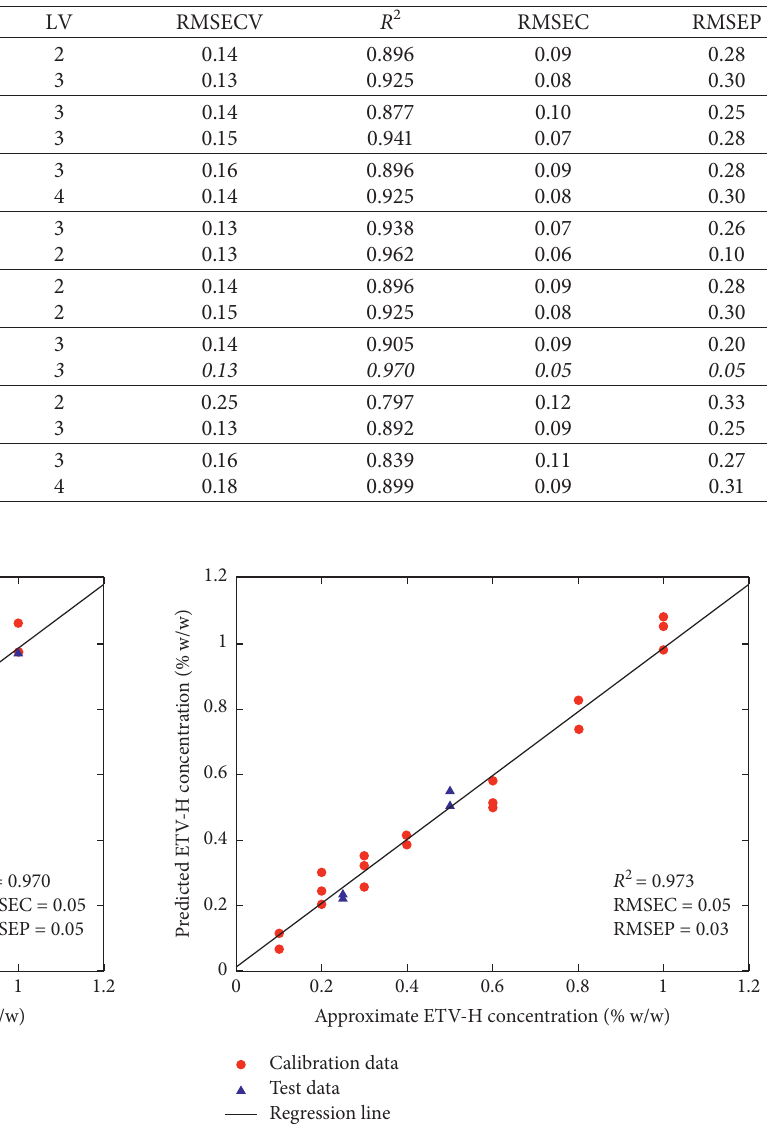
Figure 6: Approximate vs. predicted ETV-H concentrations in test set samples obtained by the best performance PLS models (baseline correction and the SNV method for data pretreatment in the wave number range of 1350–1700cm − 1 ). Approximate ETV-H con- centration referred to the approximate value of the real ETV-H